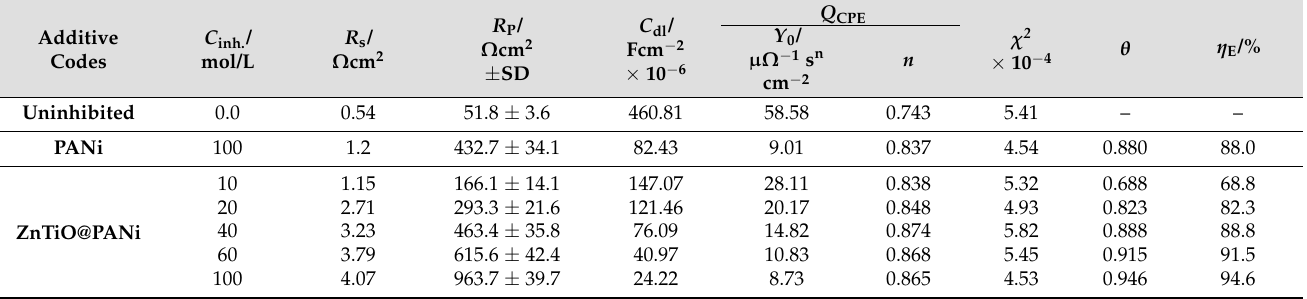
Table 3. EIS restrictions for the corrosion of CS-alloy in the acidic chloride solution and after the addition of diverse doses ZnTiO@PANi at 298